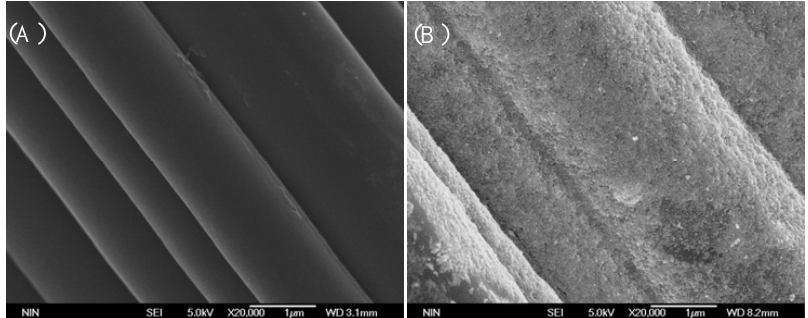
Figure 9. Zeta potential of the carbon cloth without treatment, Fe@CC after hydrothermal reaction at 200 °C, Fe@CC after calcination at 300 °C and Fe@CC with reduced